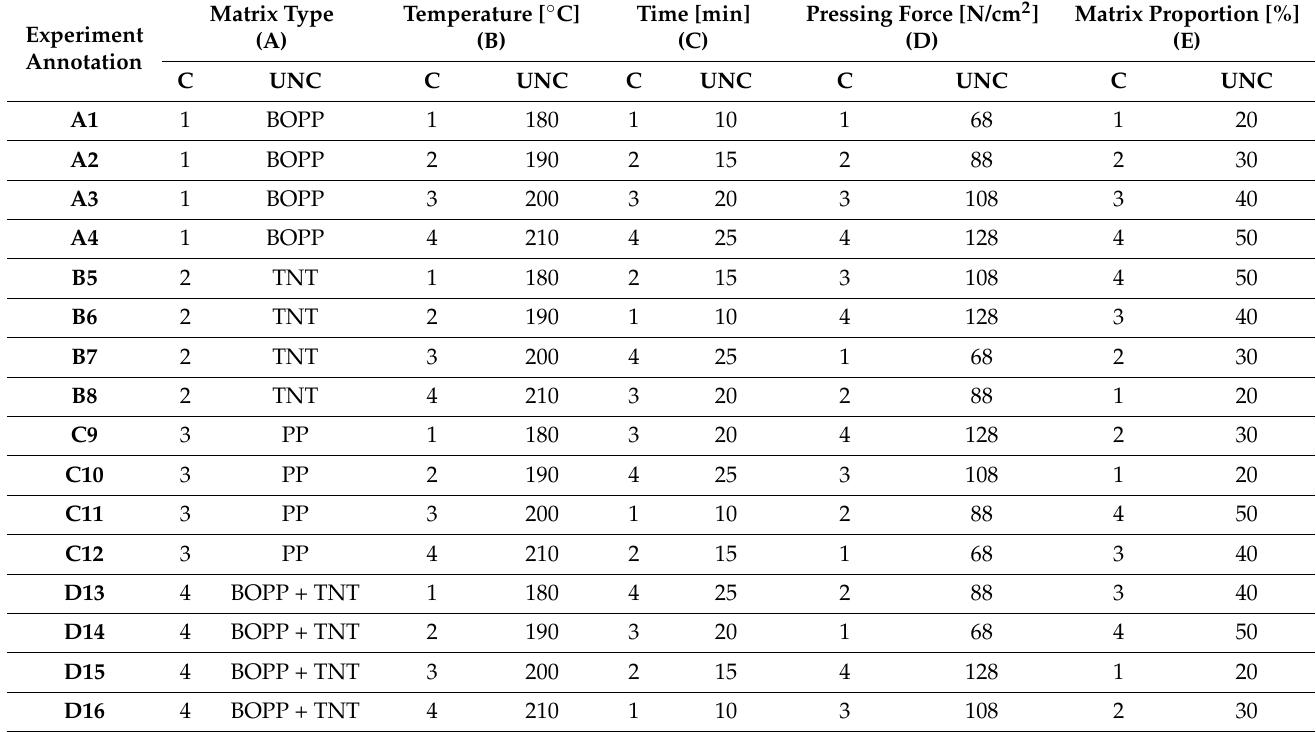
Table 2. Orthogonal array selection.